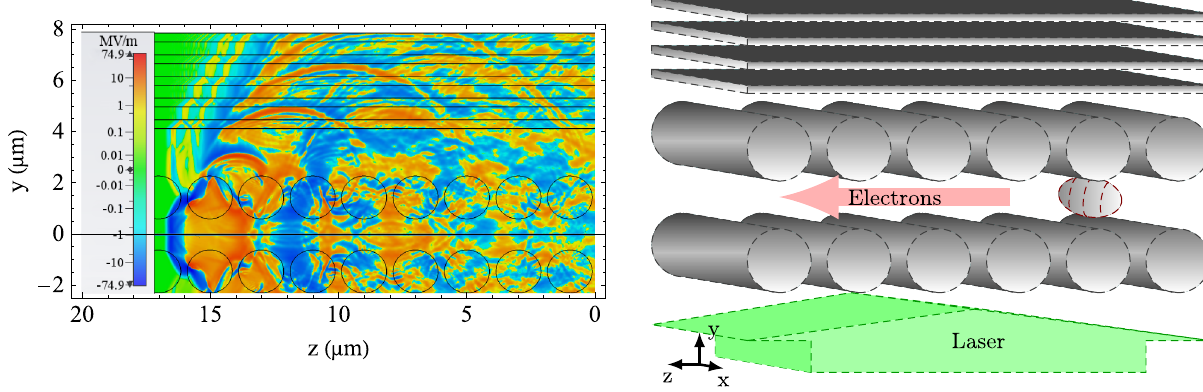
FIG. 1. Left: Longitudinal electric field of a 50 nm bunch (at z ¼ 16 . 565 μ m) with 1 fC bunch charge (left) propagating through a dielectric dual pillar structure with 2 μ m period length (right). The dimensions of the structure can be found in Appendix A.